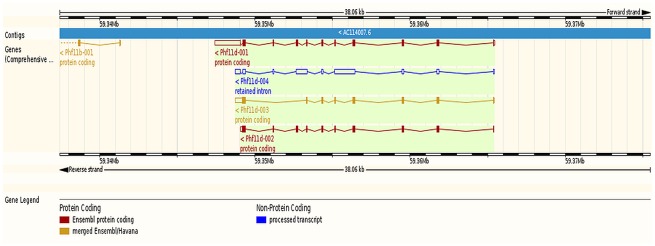
Relative location of the PHD finger protein 11 d (Phf11d) transcript isoforms associated with an alternative splicing event between microglia and macrophages (Ensembl, http://www.ensembl.org).Red denotes Ensembl protein coding, orange denotes merged Ensembl/Havana protein coding, and blue denotes processed transcript non-protein coding.